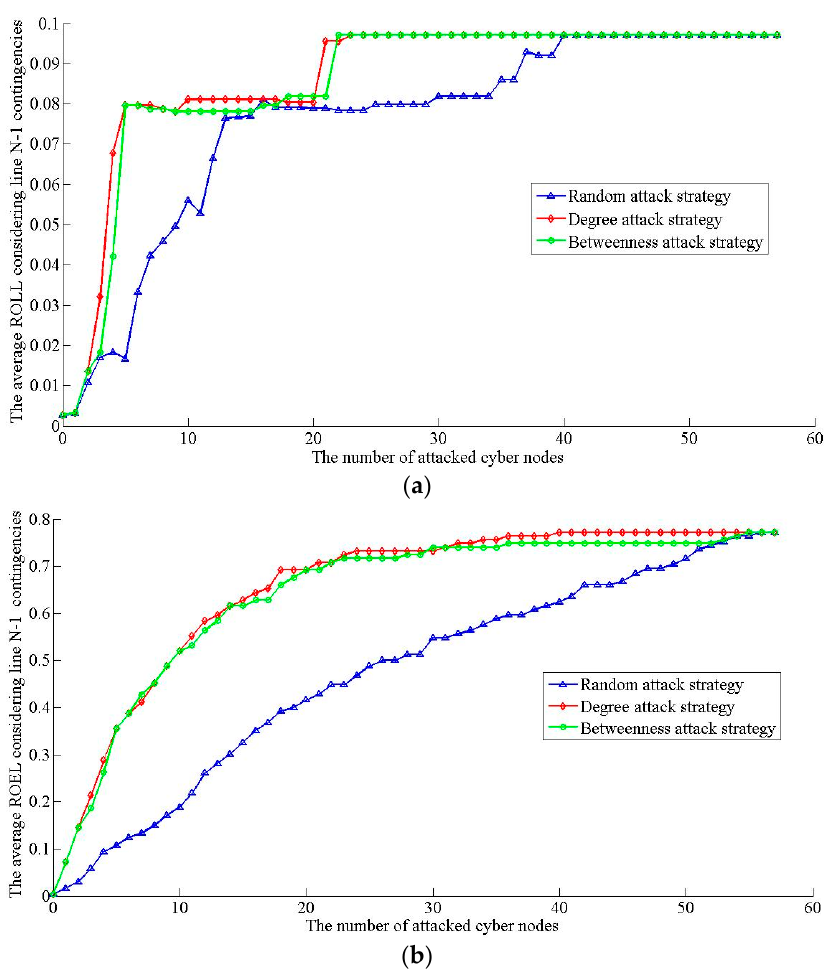
Figure 4. Under different attack strategies, the average vulnerability indices of CPPS considering line N − 1 contingencies: ( a ) ROLL; ( b ) ROEL.